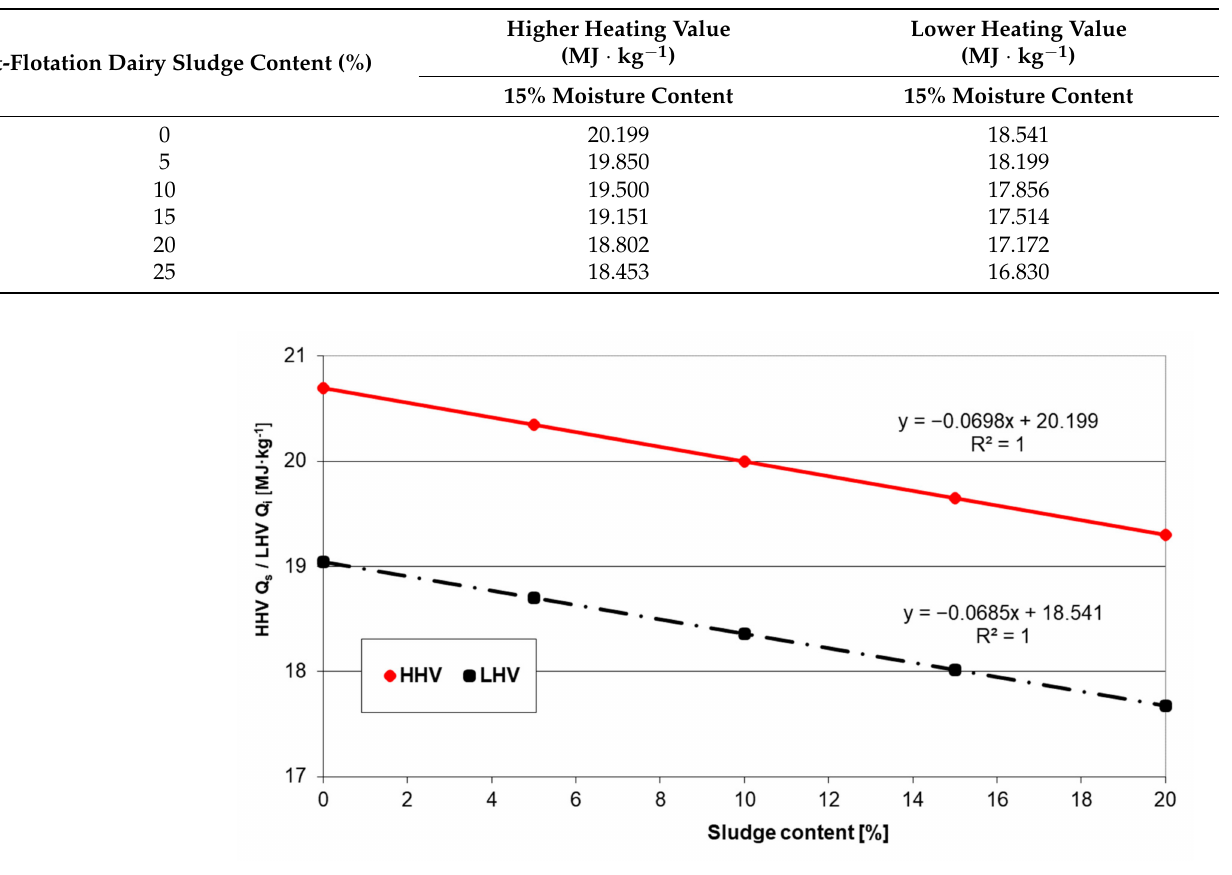
Figure 9. Dependencies of the HHV and the LHV of mixtures (at 15% moisture) with sawdust on the content of post-flotation dairy sewage